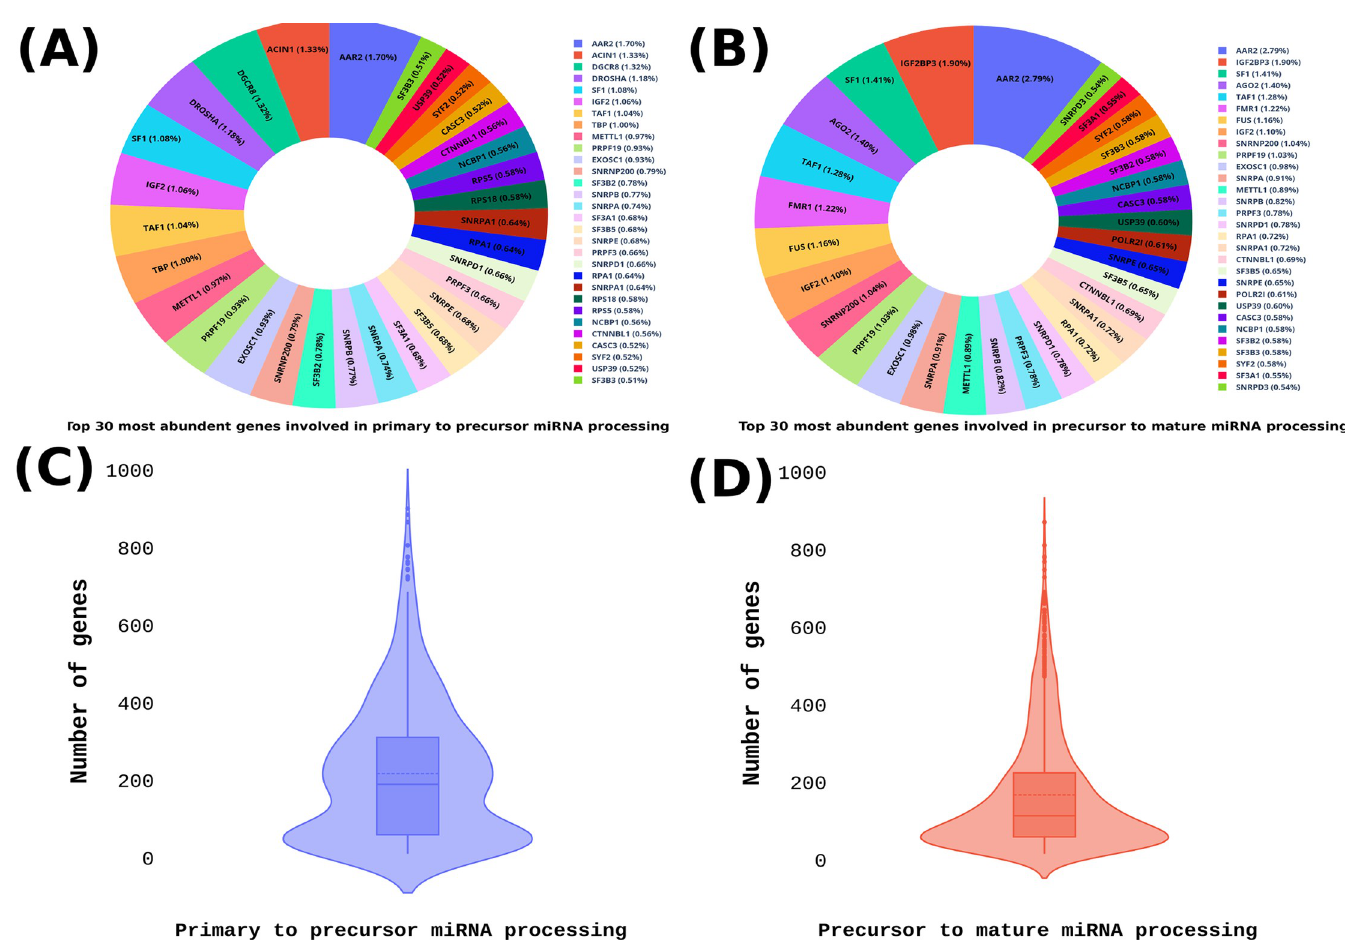
Fig 6. The most common genes across the conditional causal networks and distribution of genes across the networks. (A) The top 30 most common genes involved in the primary to precursor processing. (B) The top 30 most common genes involved in precursor to mature miRNA processing. The violin plots show the number of genes distribution across the identified networks involved in miRNA processing from primary to precursor (C), and precursor to mature miRNA(D).